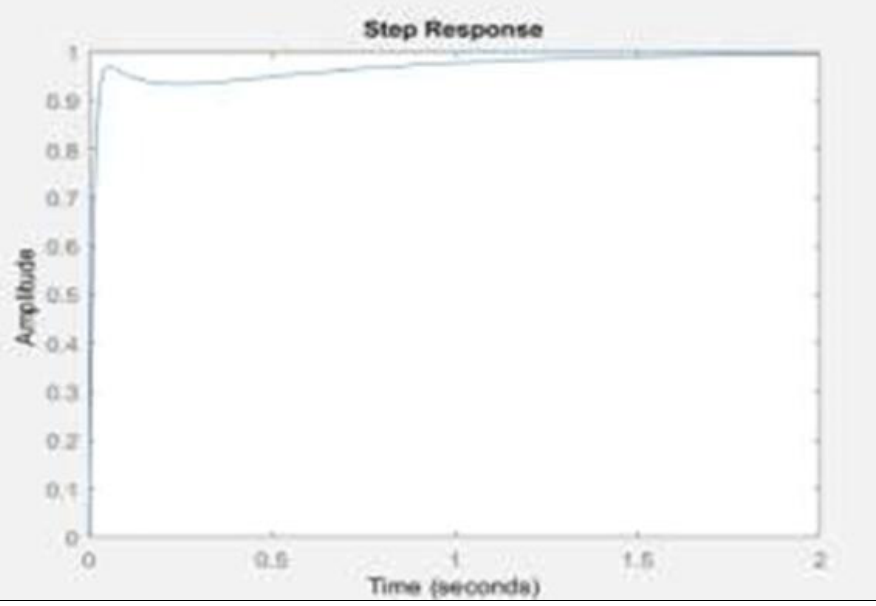
Figure 5: Amplitude of the Transfer Function Source: Author,